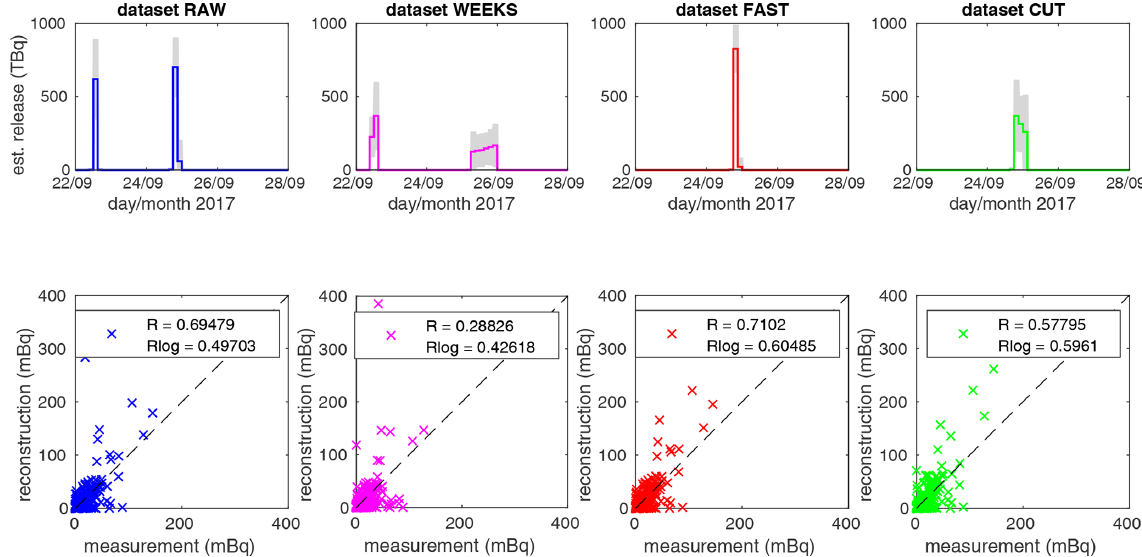
Figure 11. Estimated (est.) source terms for location 2, Mayak, using SRS matrices computed using the FLEXPART atmospheric transport model (top row) associated with scatterplots between the IAEA-reported measurements and reconstruction using specified dataset (bottom row). The coloring of panels is the same as in Figs. 7 and